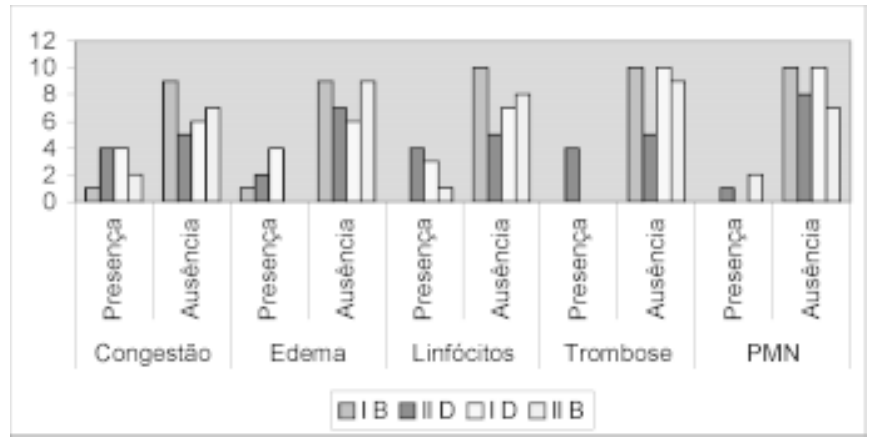
FIGURA 4 - OcorrŒncia das altera(cid:231)ıes histopatol(cid:243)gicas em veias expostas ao ultra-som nos modos cont(cid:237)nuo e pulsado 3W/cm 2 e 3